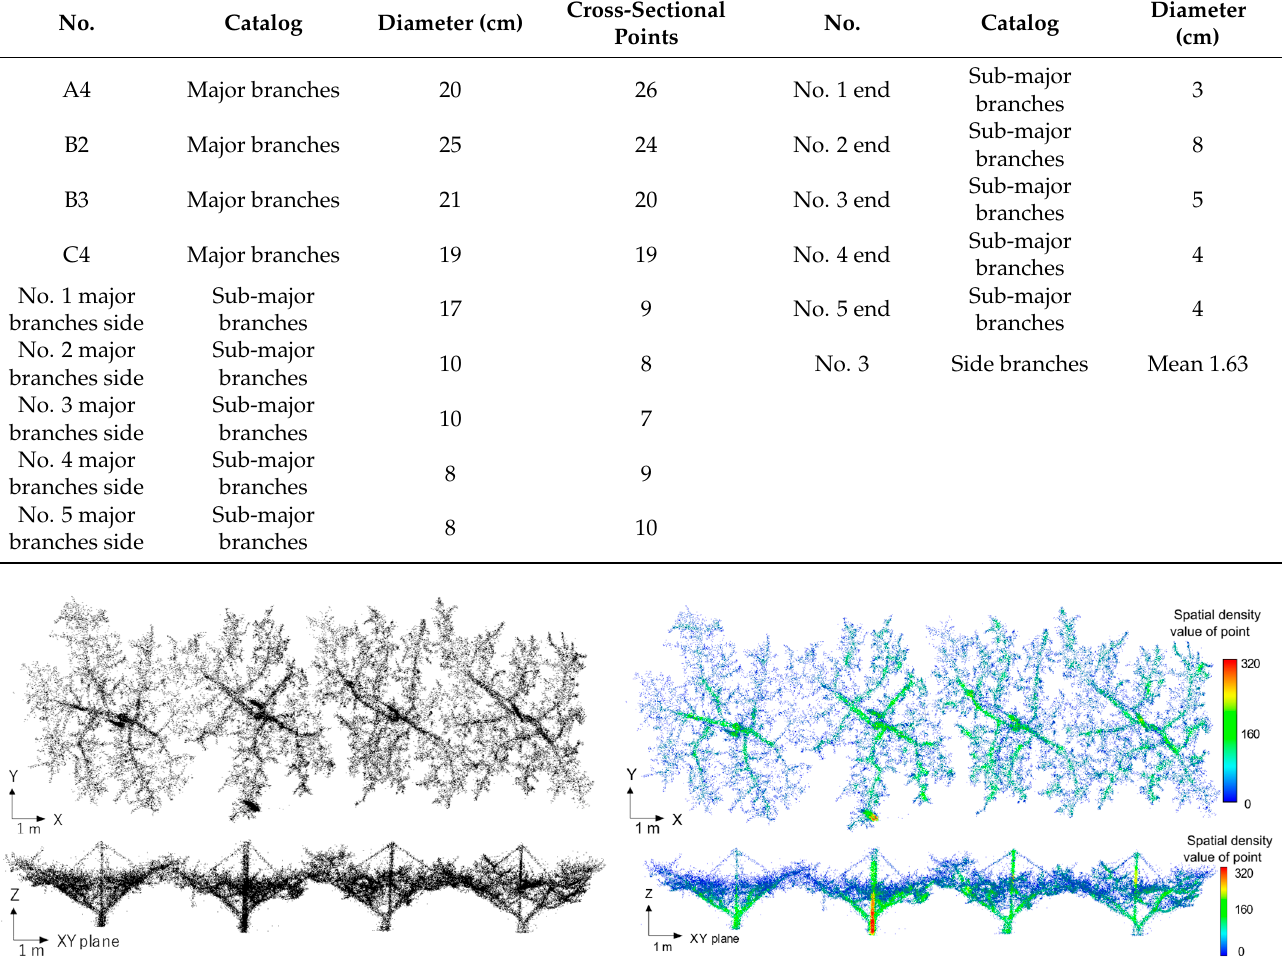
Figure 9. Classification of the branches using the spatial density value of the points (gray points represent fine branches below μ + 1 σ . Other colors represent thick branches above μ + 1 σ ; μ : arith- metic mean; σ : standard deviation). (A) histogram made be the spatial density value of the point. (B) the point cloud model from 24 December 2021 after classification.